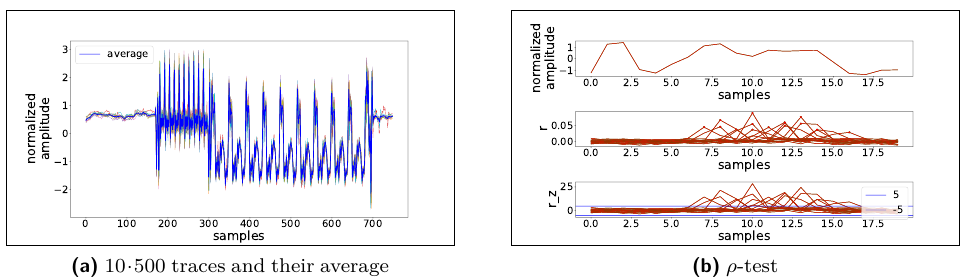
Figure 15: Leak at optimization level O3, at 10 cm in a home environment. The AES-128 encryption is clearly visible (a). The ρ -test detects the POIs which show significant correlation with the leak variable